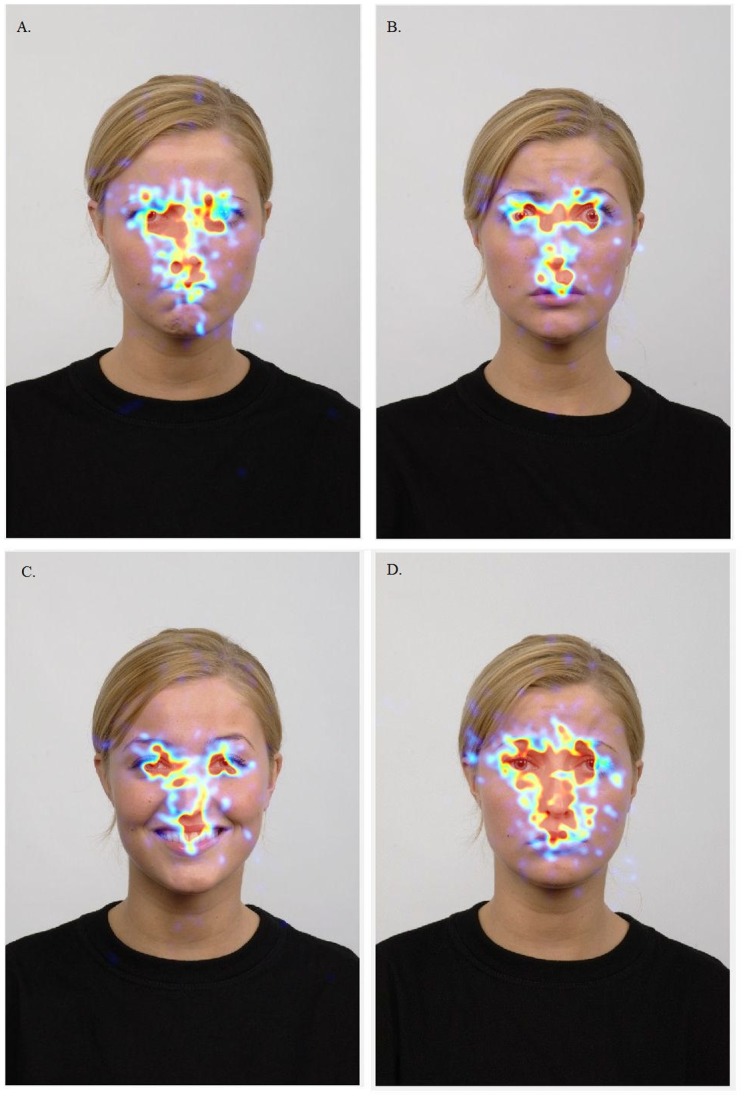
Heatmaps for gazing behavior across all participants for four emotions.Example heatmap for gazing behavior at different emotional expressions, namely (A) Angry (B) Fearful (C) Happy and (D) sad.